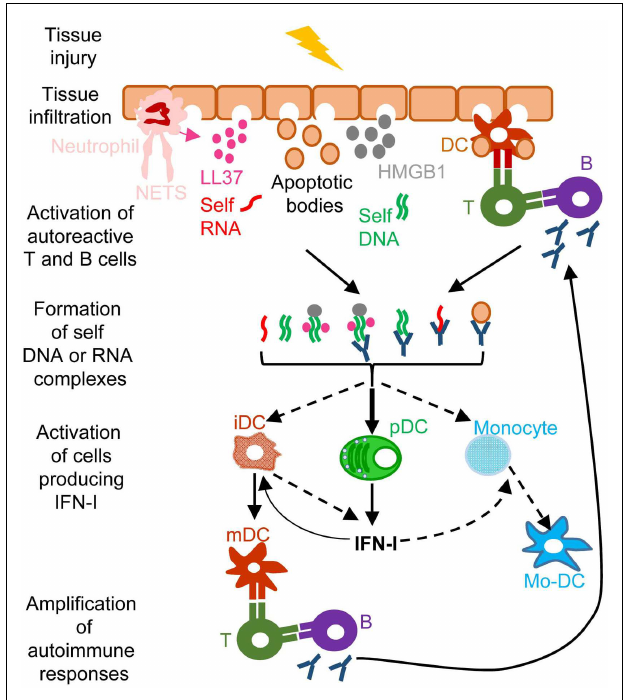
FIGURE 4 |A simplified model of the deleterious role of IFN-I in several autoimmune diseases .When exposed to different kinds of injuries (microbial infection, commensal microbiota dysbiosis, chemical or physical insults), healthy tissues can undergo cell damage and death.These events induce the release of apoptotic bodies encompassing self RNA or DNA. Neutrophil recruitment and activation in inflamed tissues can also constitute a potent source of self nucleic acids, through the release of neutrophil extracellular traps (NET). Self RNA or DNA can associate with cationic peptides (e.g., LL37) as shown in psoriatic patients or with inflammatory molecules (e.g., high mobility group box 1, HMGB1) to generate nanoparticles that are extremely efficient for IFN-I production by pDC and eventually other cell types. pDC can also be efficiently activated for IFN-I production by immune complexes (ICs) generated by the association between self nucleic acids and auto-antibodies as frequently found in the serum of systemic lupus erythematosus patients. IFN-I promote the differentiation and/or the maturation of antigen-presenting cells, in particular different subsets of DC. Activated DC can then present self-antigens for activation of auto-reactiveT CD4 + cells, including follicular helper lymphocytes, which in turn activate auto-reactive B cells for auto-antibody secretion, leading to a vicious circle of reciprocal activation between innate and auto-reactive adaptive immune cells. iDC, immature DC; mDC, mature DC; Mo-DC, monocyte-derived DC. See main text for further